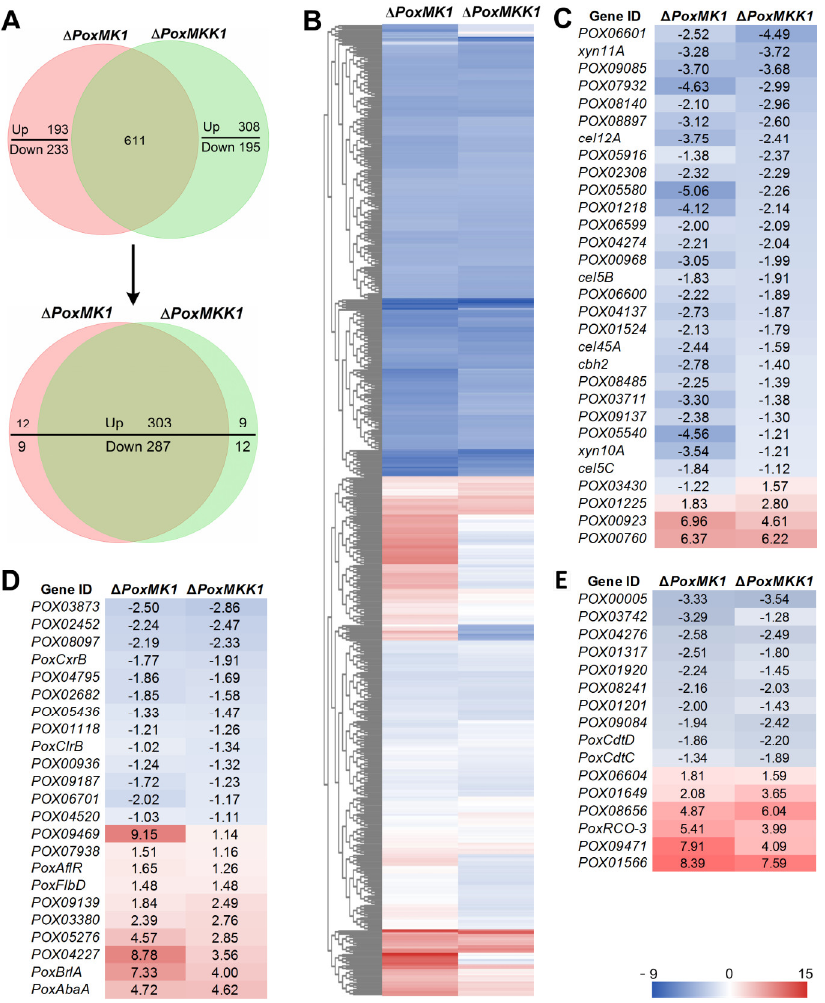
Figure 7. Regulon comparison of PoxMK1 and PoxMKK1 deduced by Avicel for 24 h. ( A ) Number of co-regulated differentially expressed genes (DEGs). ( B ) Heatmap illustrating co-regulated DEGs; ( C − E ) DEGs encoding predicted CAZymes, TFs, and sugar